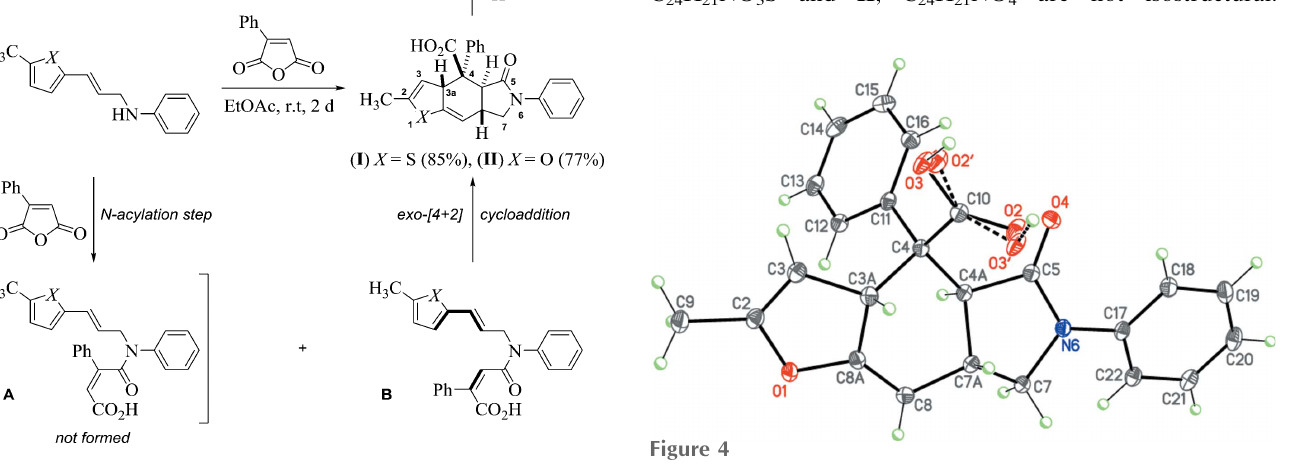
Figure 2 Synthesis of (3a SR ,4 RS ,4a RS ,7a SR )-5-oxothieno[2,3- f ]isoindole-4-carb- oxylic acid (I) and (3a SR ,4 SR ,4a RS ,7a SR )-5-oxofuro[2,3- f ]isoindole-4- carboxylic acid (II).